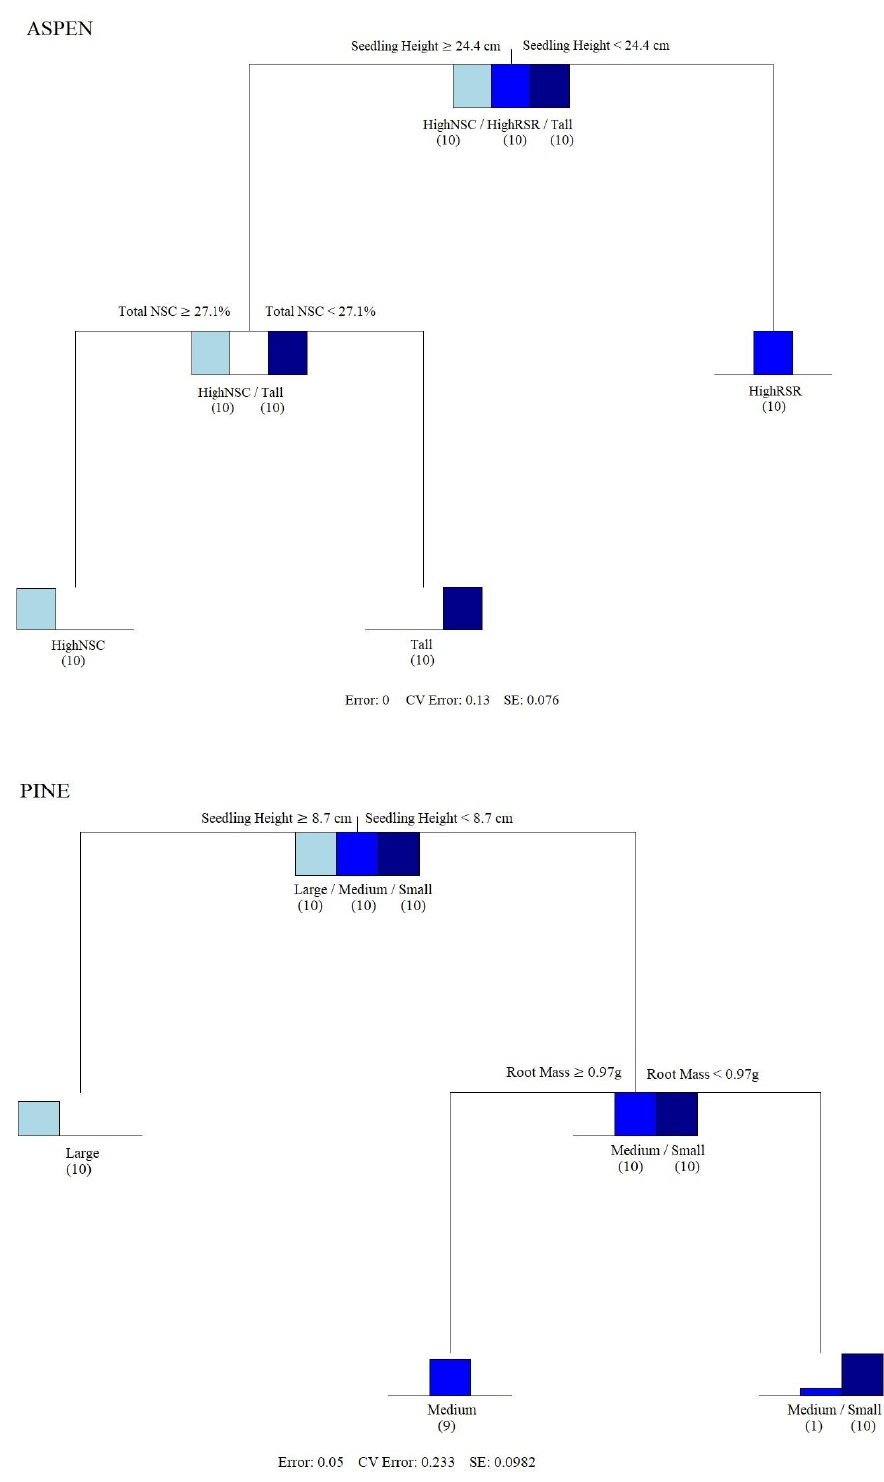
Figure A2. Multiple Regression Tree (MRT) analysis based on the initial aspen seedling characteristics ( top ) to determine the contribution of variables determining each seedling type. This tree explained 100% of the total variance, and the vertical depth of each split is proportional to the variation explained. The numbers below each of the splits correspond to the number of seedlings by corresponding seedling type. MRT analysis ( bottom ) of initial pine seedling characteristics that determine the contributing factors in determining seedling type. This tree correctly explained 95% of the total variance, where the vertical depth of each split is proportional to the variation explained.